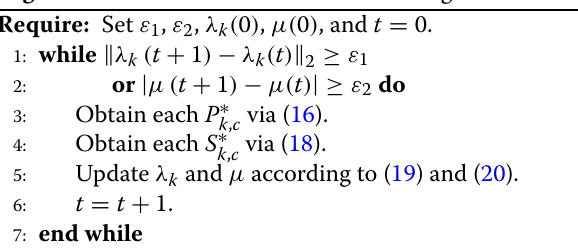
Algorithm 1 Iterative resource allocation algorithm